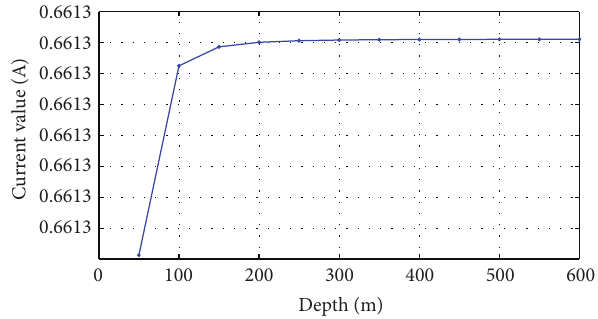
Figure 8: Curve of the maximum current value with the buried depth.